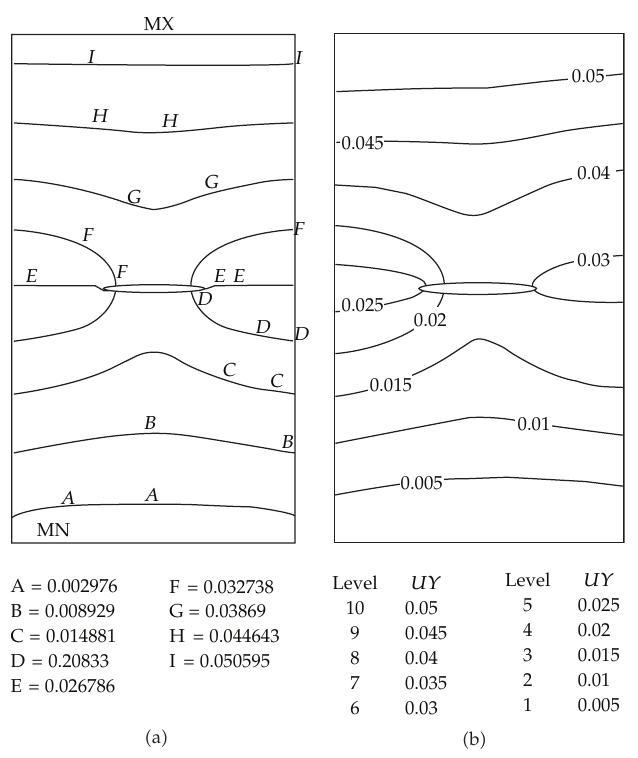
Figure 4: Vertical displacement contour for MT specimen with a/ W (cid:11) 0 . 4: (cid:2) a (cid:3) ANSYS (cid:2) b (cid:3) proposed